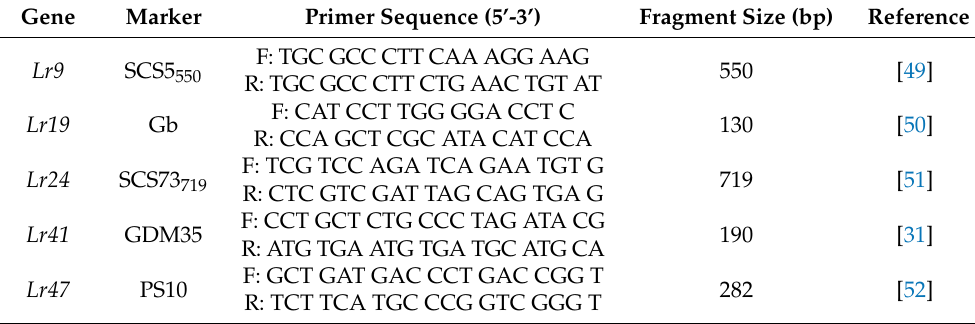
Table 2. DNA markers linked to effective leaf rust resistance genes in wheat. Gene Marker Primer Sequence (5’-3’) Fragment Size (bp)